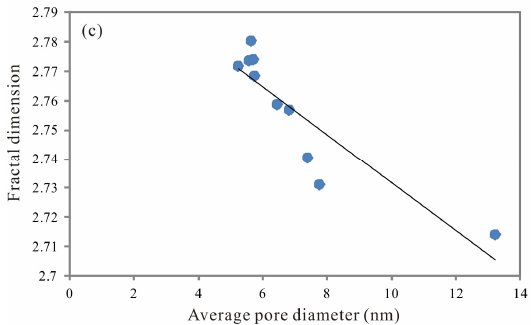
Figure 11. Relationships between fractal dimension and SSA ( a ), PV ( b ) and average pore diameter ( c ).